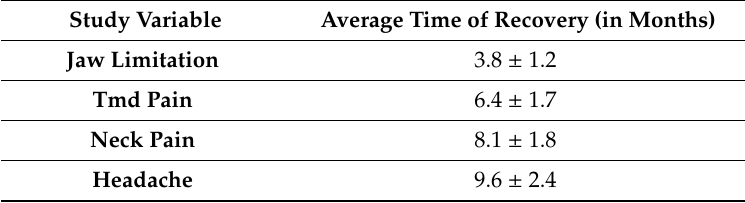
Table 2. Average time of recovery (in